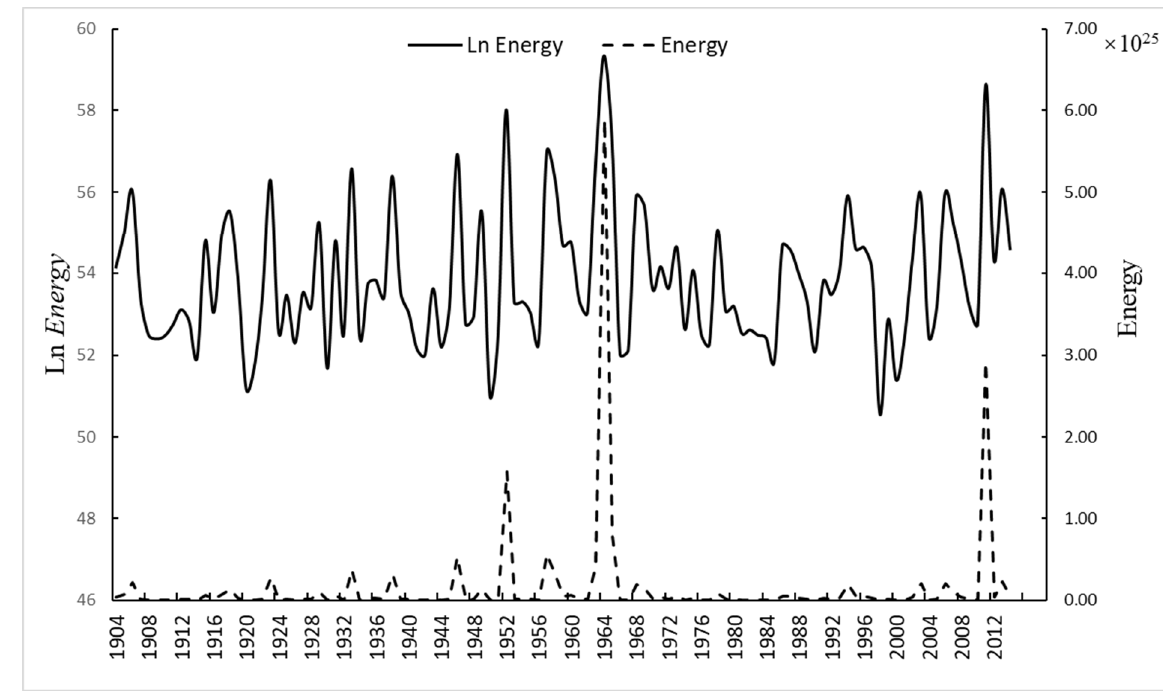
Figure 3. Graph of energy release versus time for the plate boundary NA-PA: The dotted line represents the energy release of the earthquakes, and the solid line represents the energy release after transformation into natural logs. This is one example from all 28 plate boundaries.